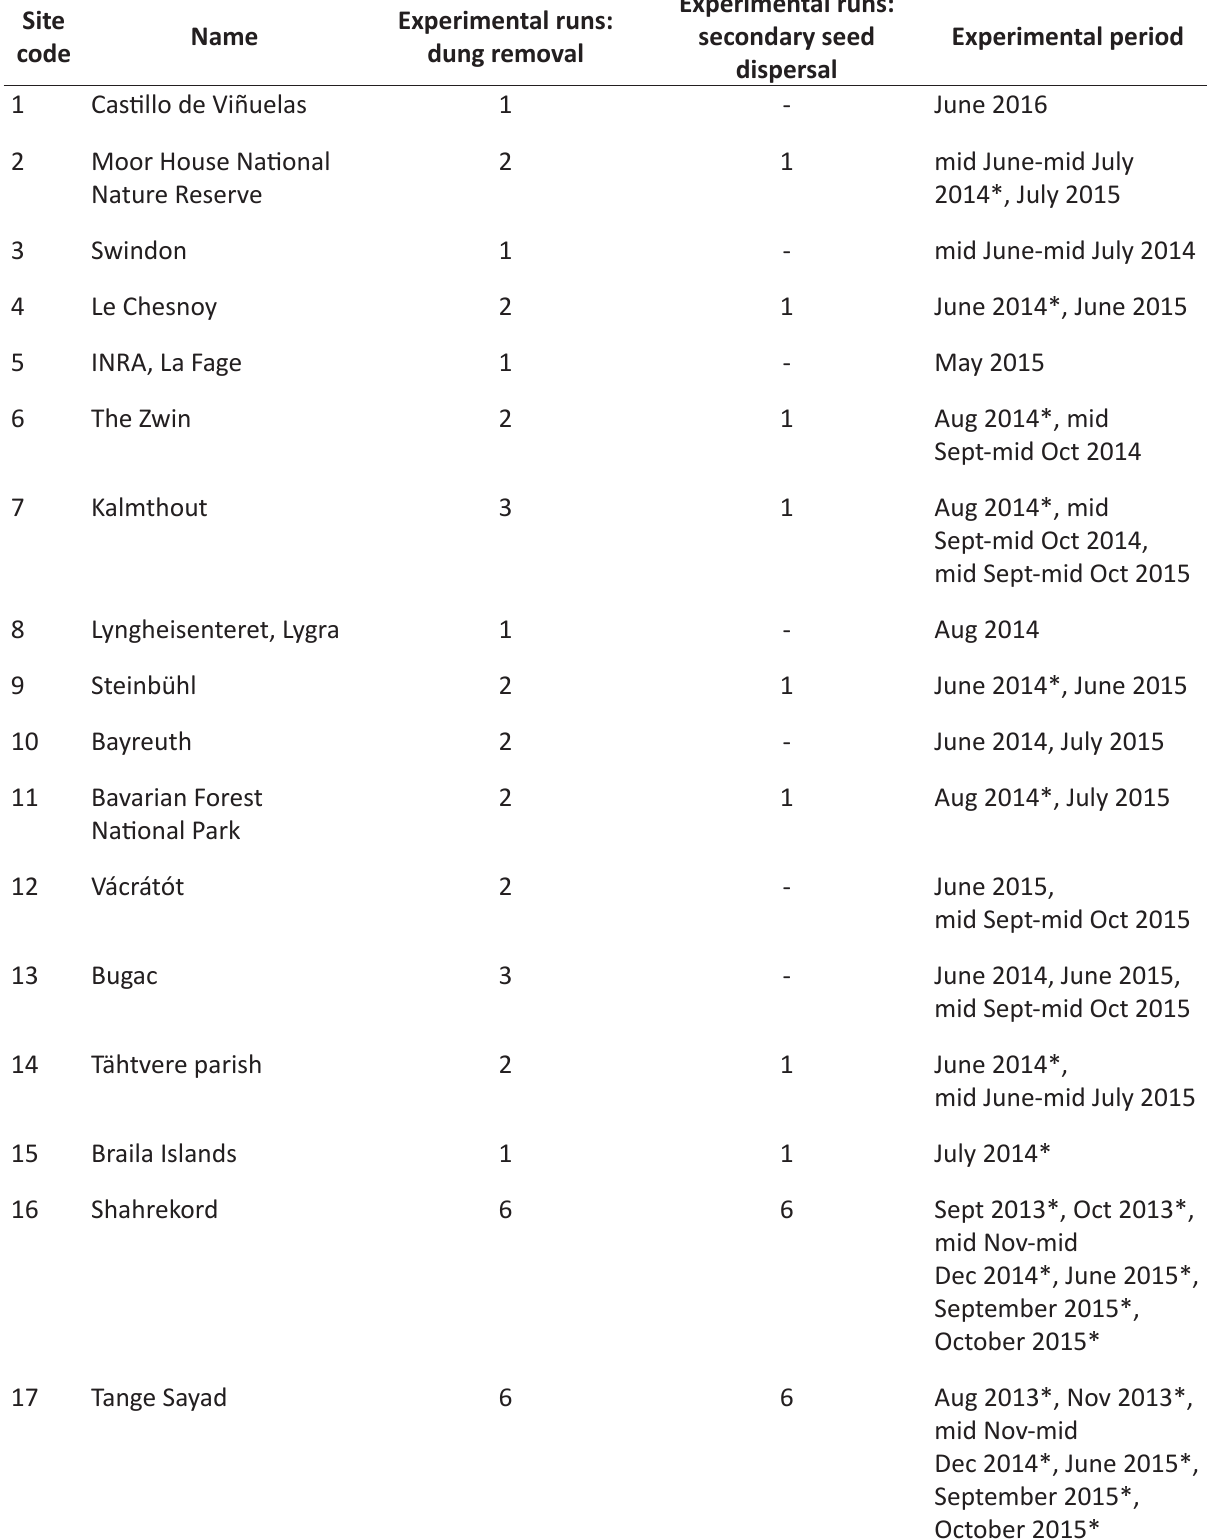
Table 2. Number of experimental runs for dung removal and secondary seed dispersal experiments and the timing of the experiments in each study site. Secondary seed dispersal experiments were performed during experimental periods marked with asterisks (*), dung removal experiments were run during each experimental period and at each